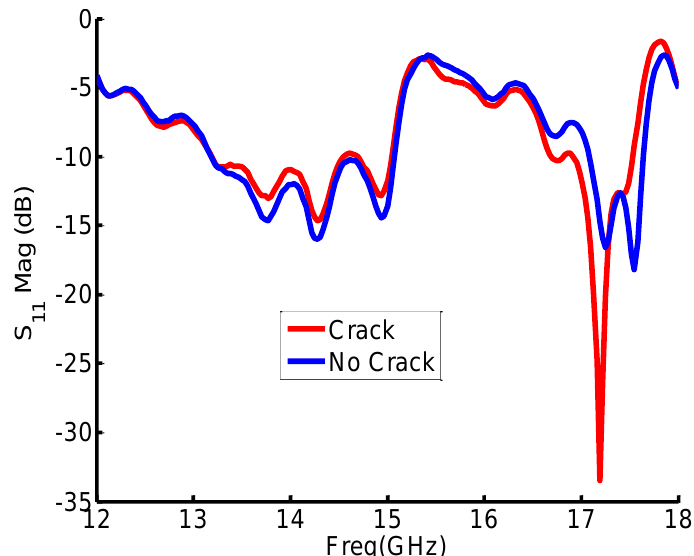
Figure 4. Reflection coefficient magnitude from cracked and no-cracked surfaces at 0.5 mm